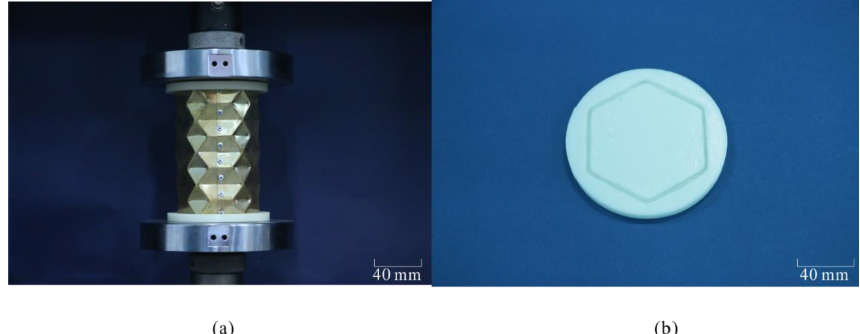
Figure 3. (a) Experimental setup; (b) plate with